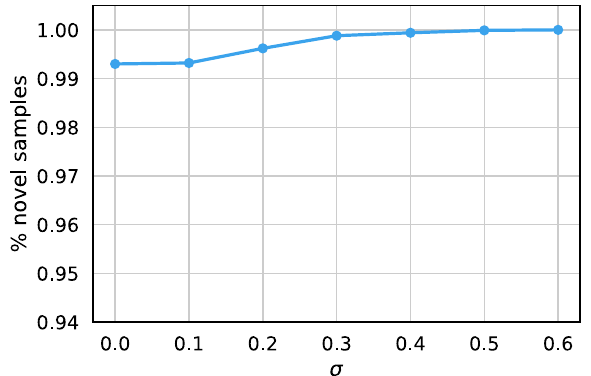
Fig. 5 Percentage of novel trajectories as a function of the standard deviation of the Gaussian noise. The mean of the Gaussian was chosen to be the zero vector. The noise was added to the representations of the Encounter nodes. For each value of σ ∈ {0.0, 0.1, 0.2, 0.3, 0.4, 0.5, 0.6}, 20000 trajectories were generated in total, which was compared against the real trajectories.